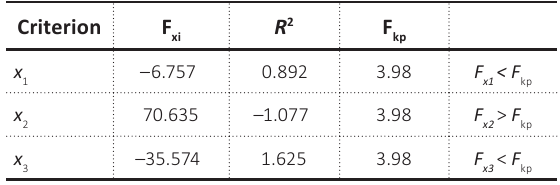
-criteria of the x Source: Authors’